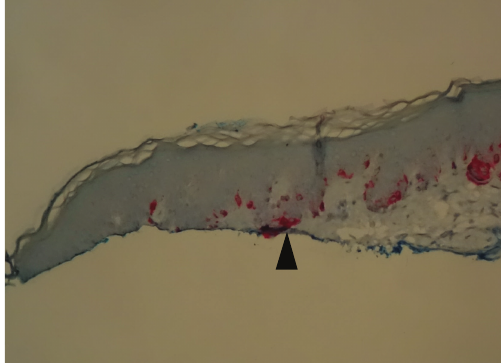
Figure 3: Melan-A highlighting subtle atypical melanocytes extend- ing to the margin, not identifiable by the H&E stain in Figure 2 (arrowhead) (Melan A; 20x).